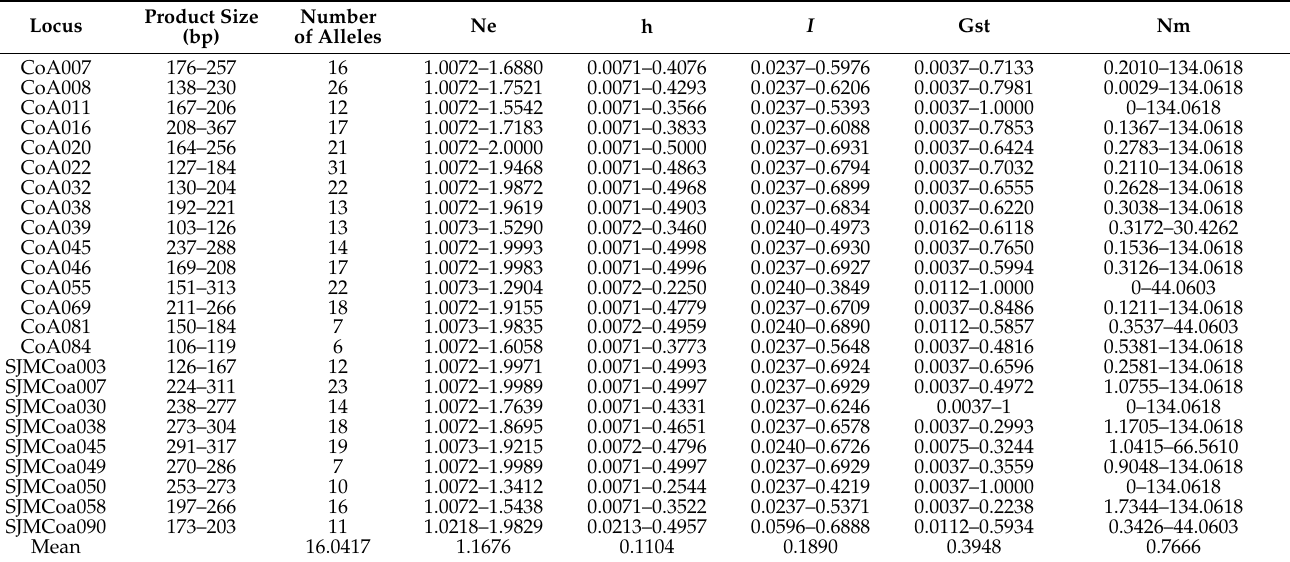
Table 3. Genetic parameters of the SSR locus analysis.